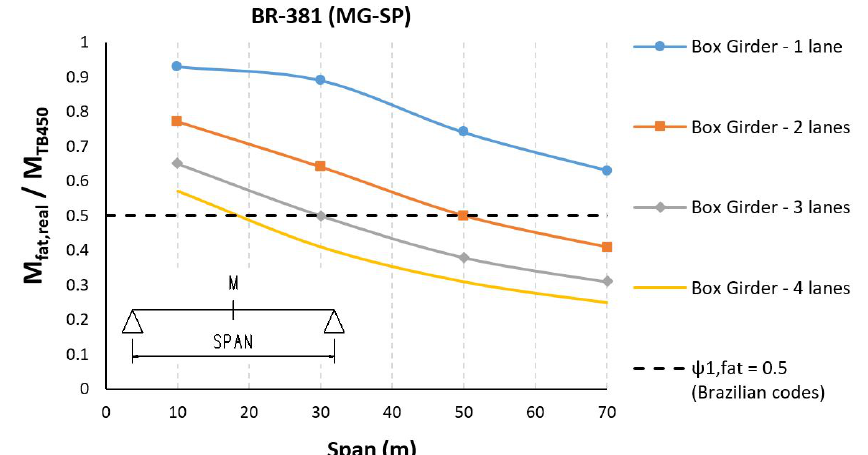
Figure 13. Bias factors for bending moment at mid-span in simply supported box-girder bridges – BR-381 (MG-SP).